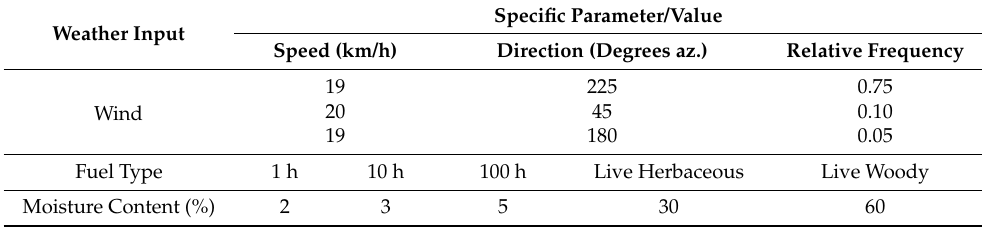
Table 3. Parameters used for fire behavior model simulations. Parameters were drawn from the Duncan Remote Automated Weather Station, and represent the 90th percentile and above winds and the 95th percentile fuel moistures for the predominant fire season in the area (1 June–30